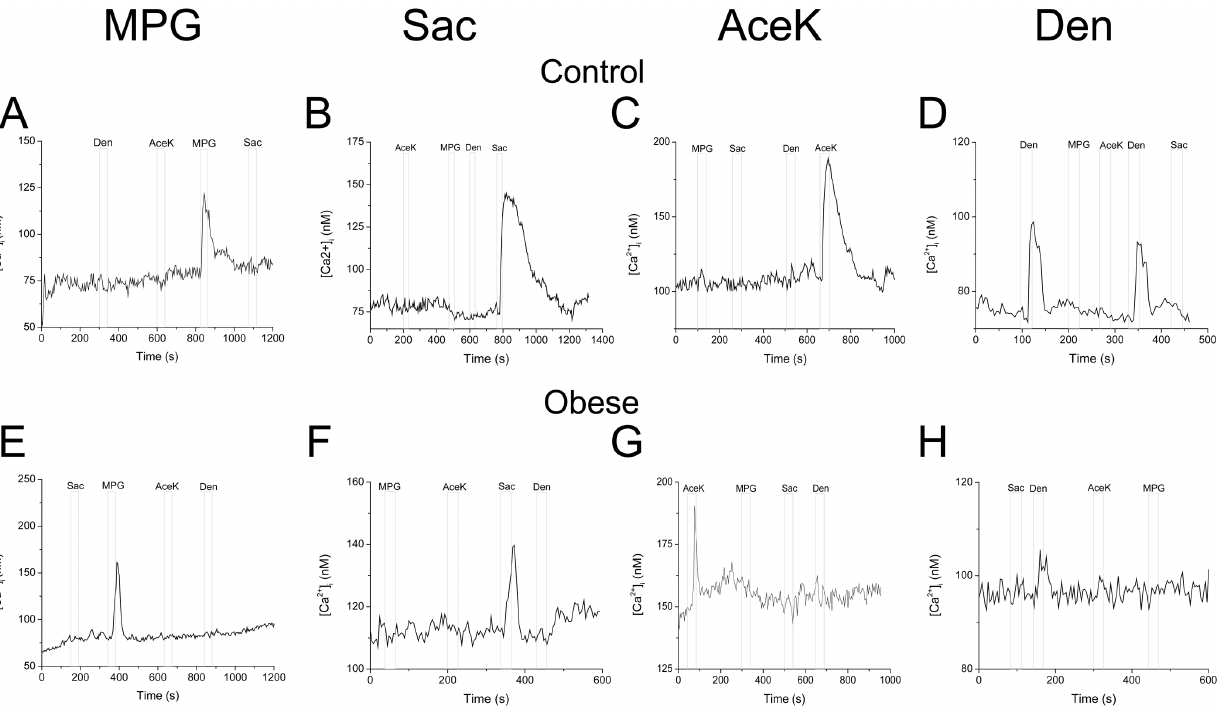
Figure 3. Taste evoked calcium signals are altered in obese mice. Representative taste evoked calcium signals are shown from both control (A–D) and obese (E–H) mice for multiple taste stimuli: umami (20 mM MPG, A, E); sweet (2 mM Saccharin, B, F and 20 mM AceK, C, G); and bitter (5 mM denatonium, D, H).